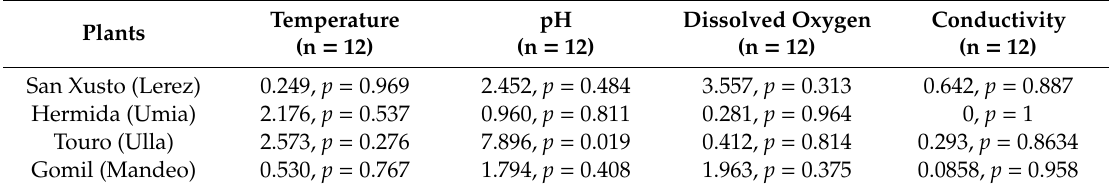
pH Dissolved Oxygen (n = 12) (n = 12)